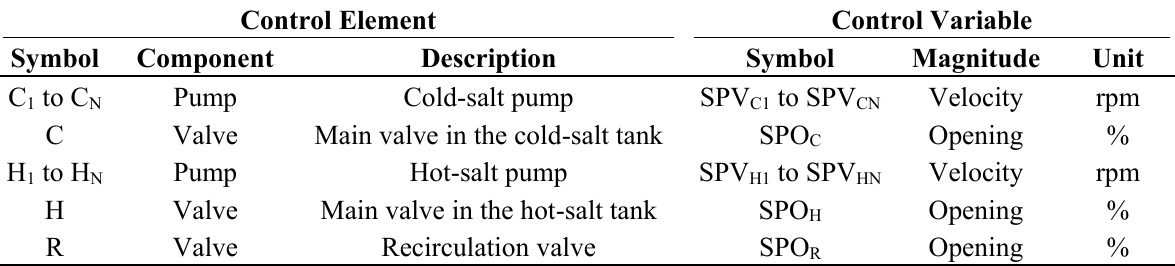
Table 1. Control elements.